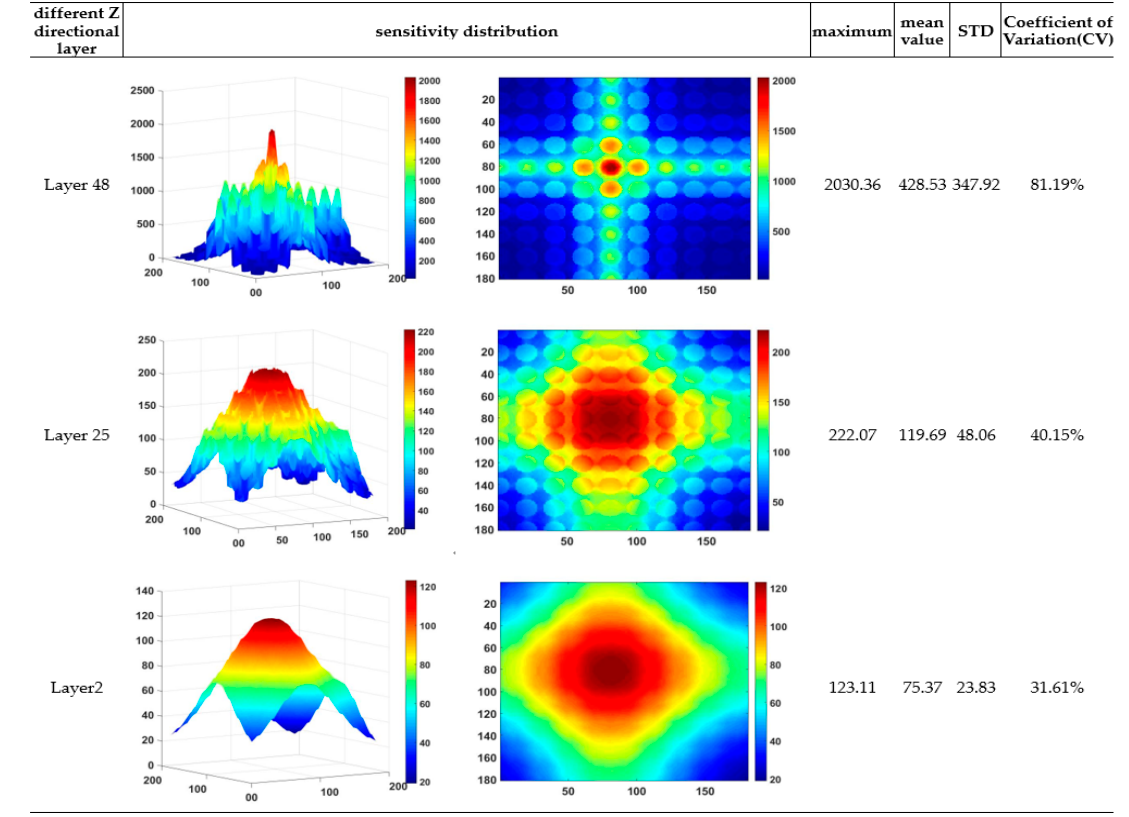
Figure 6. Capacitance array sensitivity distribution in x–y plane at different z directional layers.